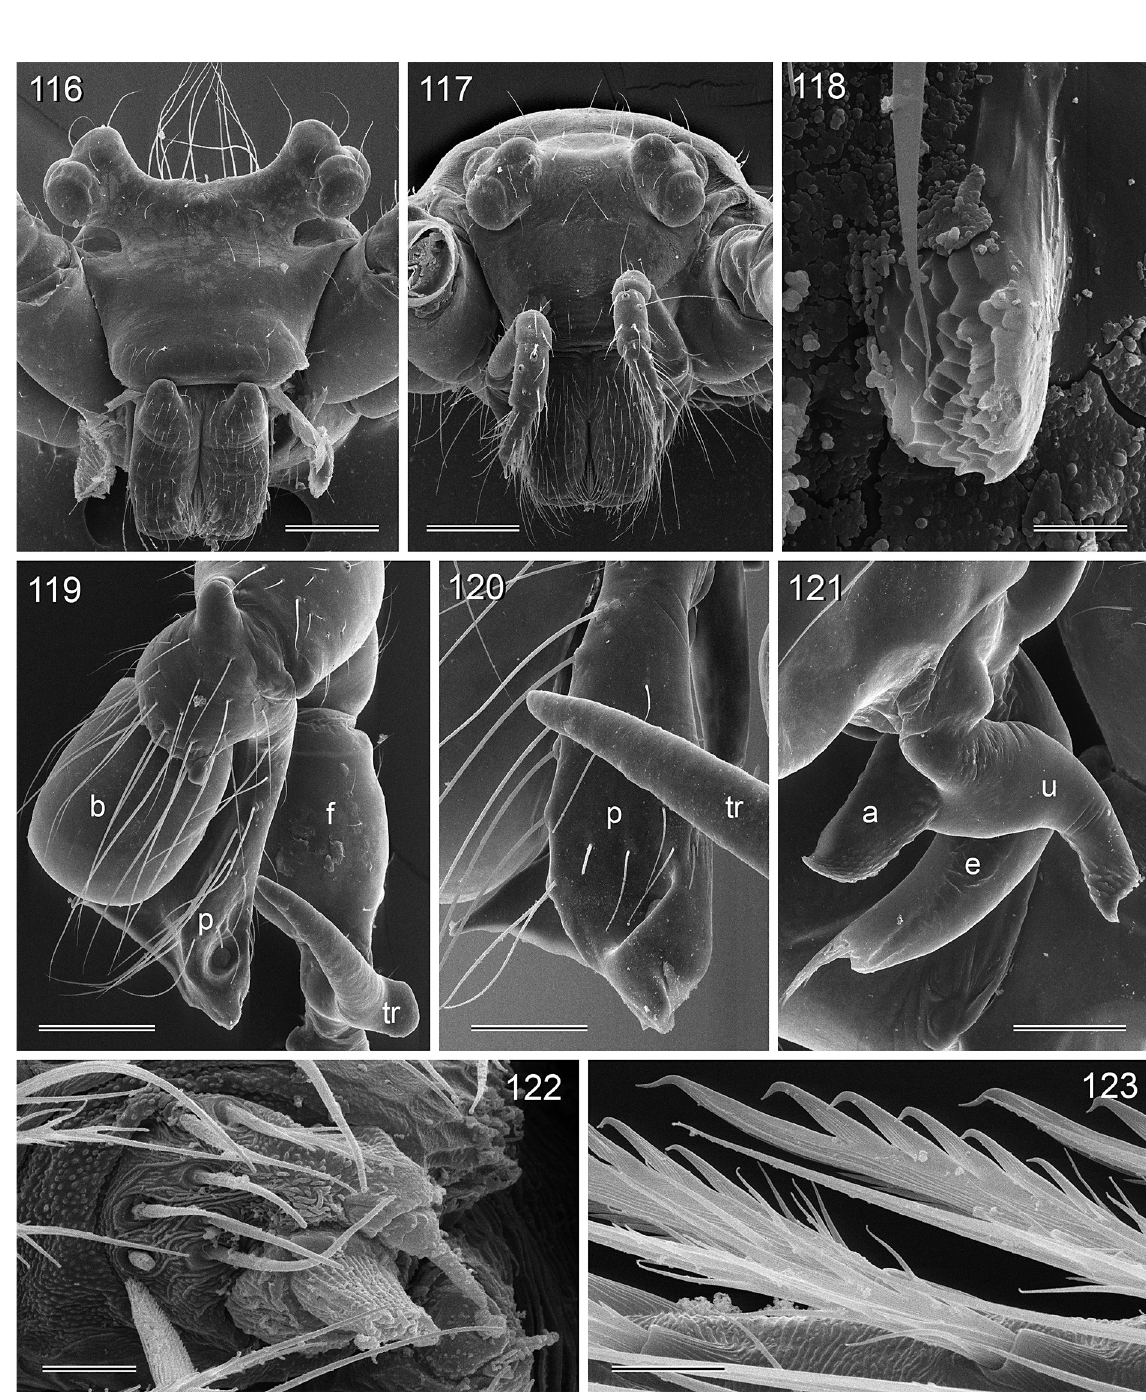
Figs 116–123. Pholcus krabi Huber, sp. nov., ZFMK Ar 15038–39. 116–117 . Male and female prosomata, frontal views. 118 . Male distal cheliceral apophysis. 119 . Left male palp, dorsal view. 120 . Left procursus (and trochanter apophysis), retrolateral view. 121 . Right bulbal processes, prolateral (slightly ventral) view. 122 . Male ALS. 123 . Comb-hairs on male tarsus 4. Abbreviations: a = appendix; b = genital bulb; e = embolus; f = femur; p = procursus; tr = trochanter; u = uncus. Scale lines: 8 µm (123); 10 µm (118, 122); 80 µm (121); 100 µm (120); 200 µm (116–117,